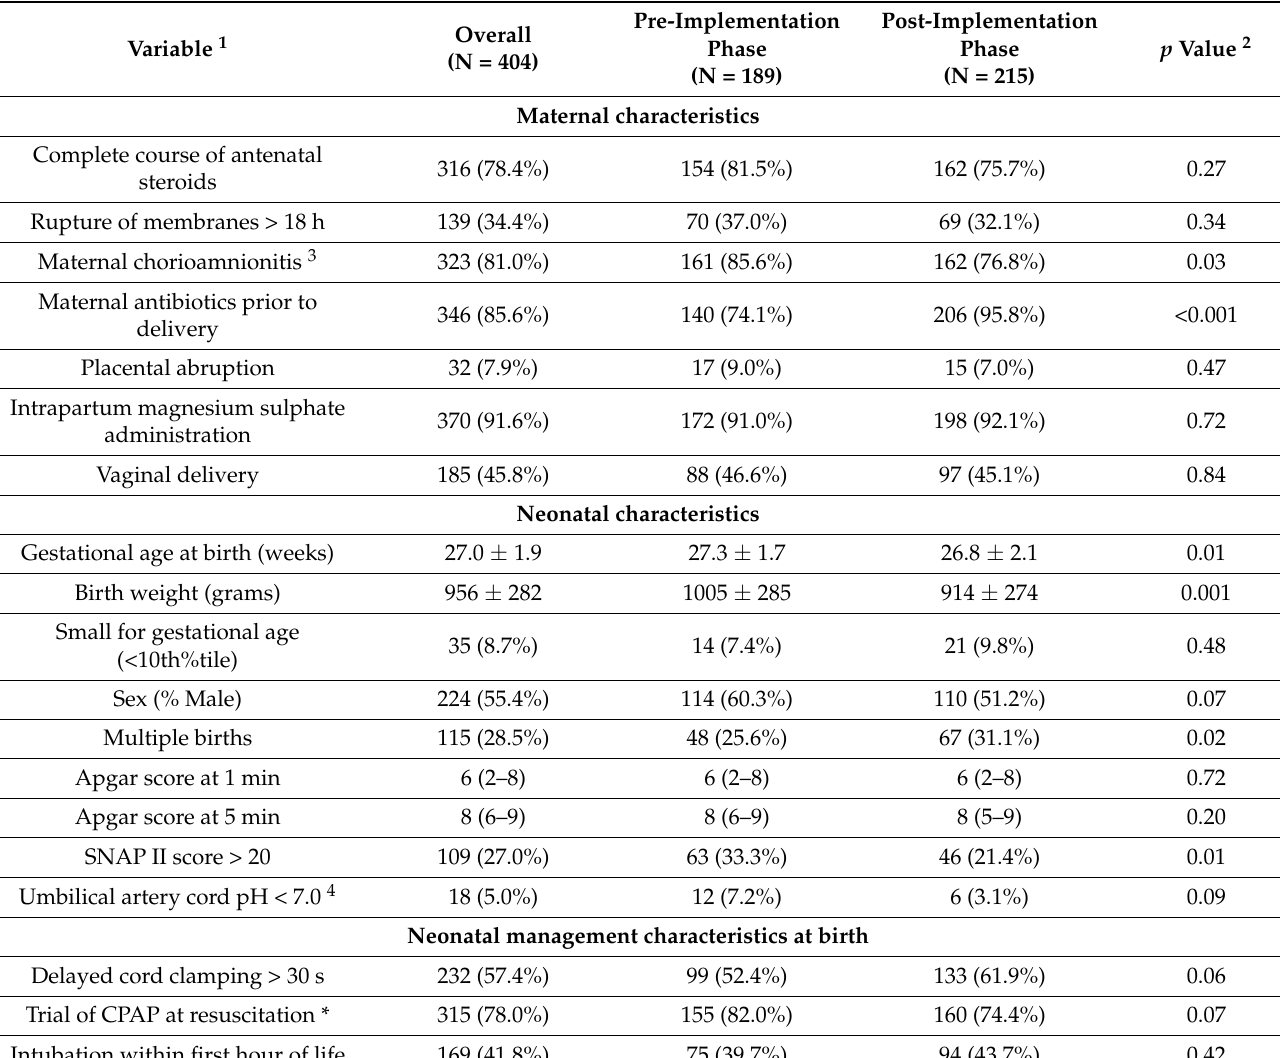
Table 1. Maternal and neonatal demographics and management